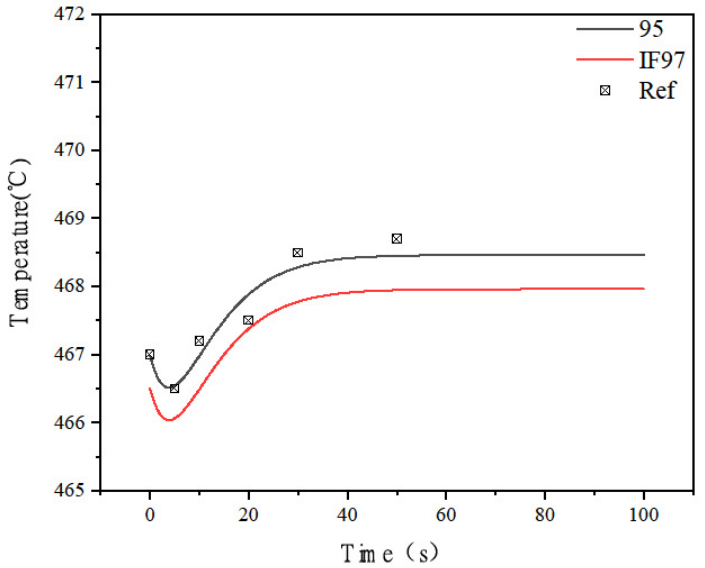
Figure 10. The outlet water temperature results of a 2% step increase in inlet water temperature.